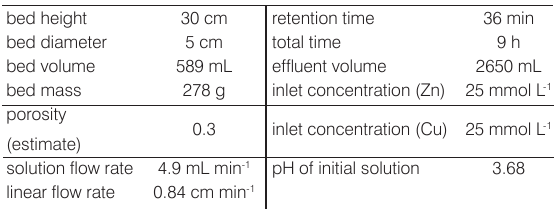
Table 1. Basic parameters of the column